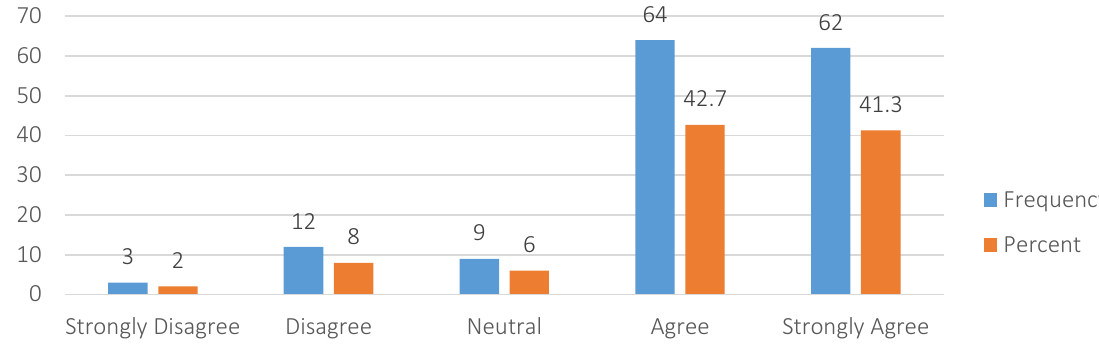
Figure 3. Shortage of skills influences the adoption of MAPs in business